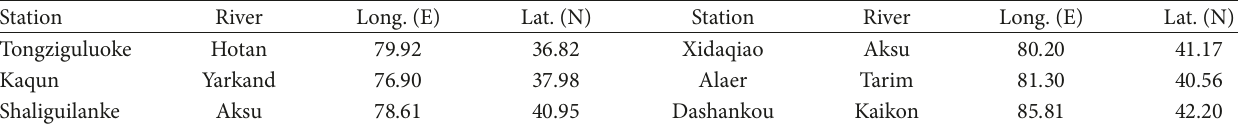
Table 2: The summaries of hydrological stations in the TRB in this